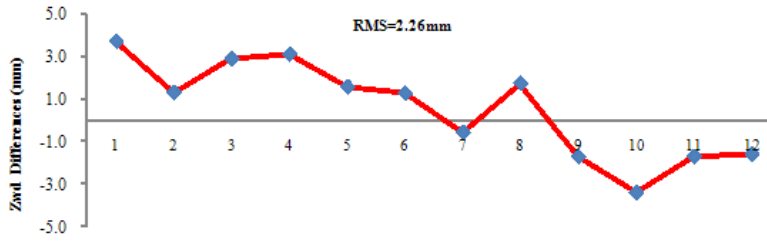
Figure 3. Differences between estimated and interpolated Zwds of